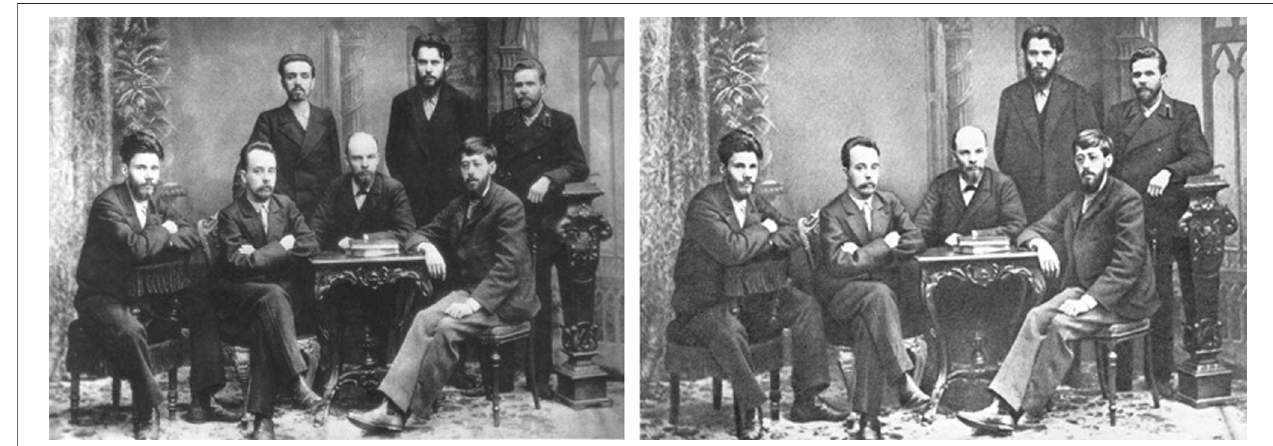
FIGURE1|Left: AlexanderMalchenko,P.Zaporozhets,andAnatolyVaneyev(standing);VictorV.Starkov,GlebKrzhizhanovsky,VladimirLenin,andJuliusMartov (sitting). Right: manipulated image with Malchenko removed. Source: Wikipedia (Wikipedia,